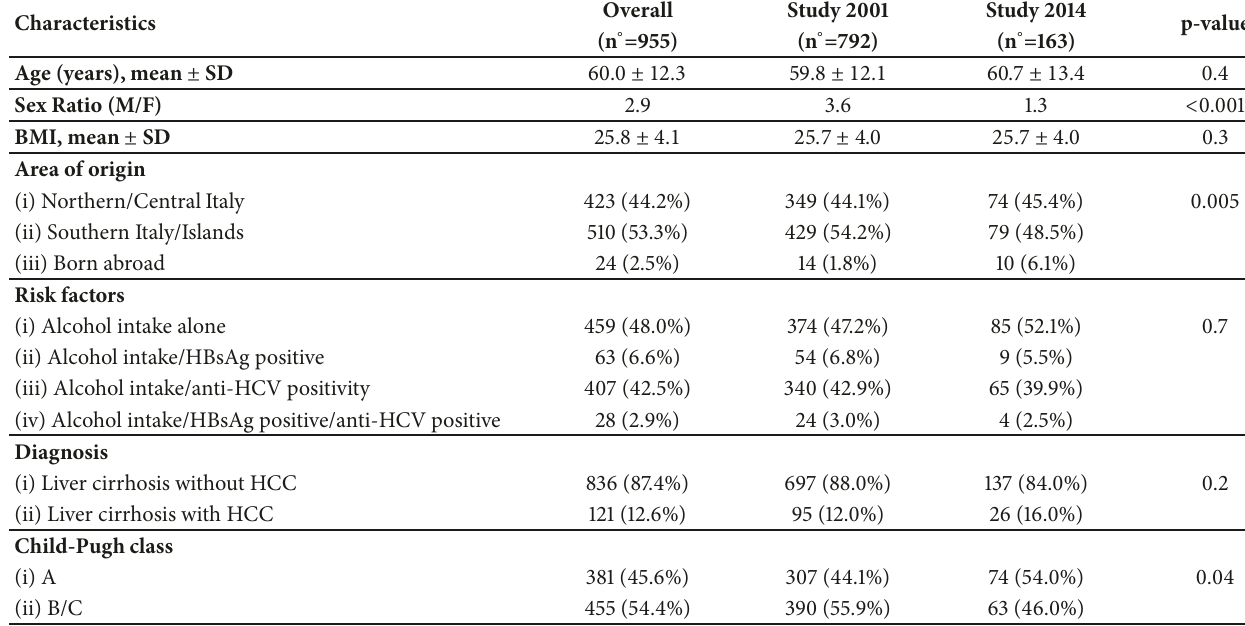
Table 5: Characteristics of 955 subjects with alcohol-related liver cirrhosis in Italy, by year of recruitment.